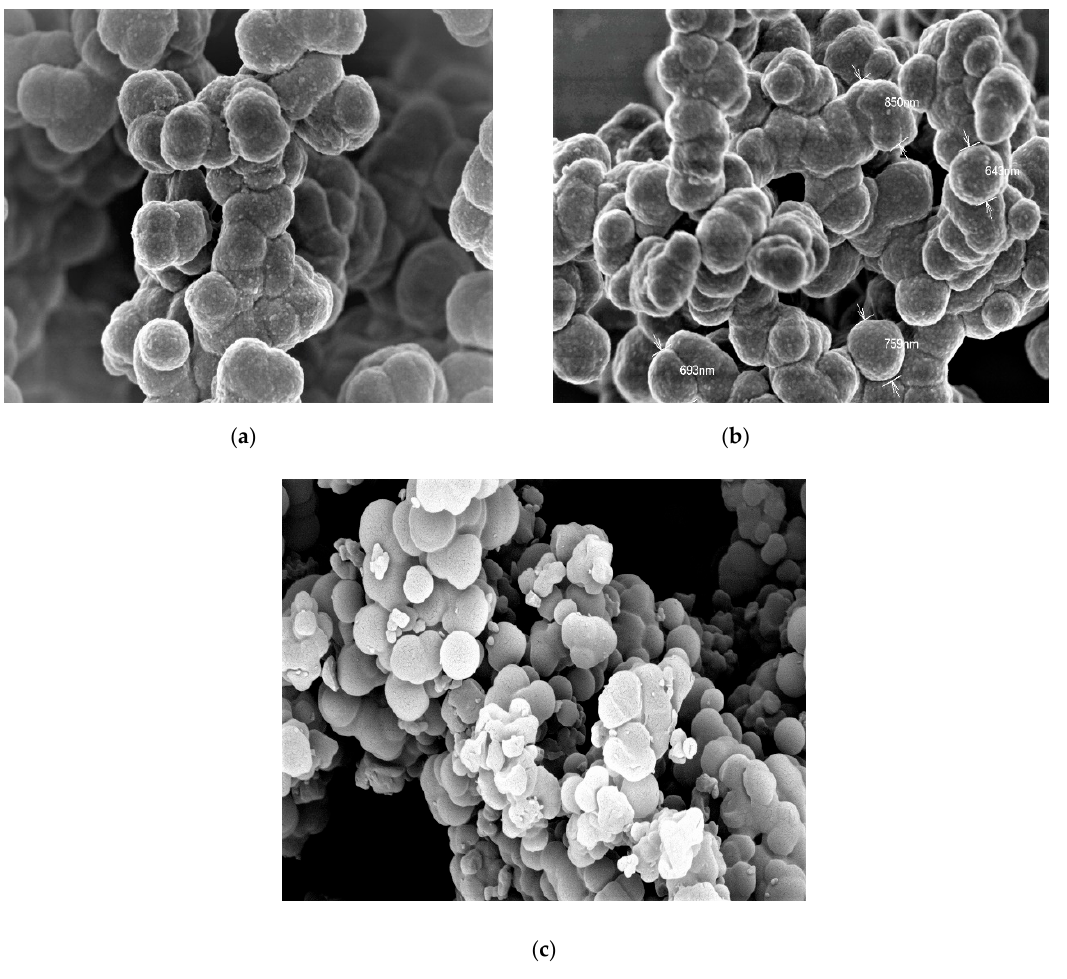
Figure 4. SEM images of ( a ) molecularly imprinted polymers (MIP) / IPU, ( b ) MIP / DU, and ( c ) nonimprinted polymer (NIP) beads. Conditions: scale bar = 2.00 µm, 3.0 kv; 27 mm x20.0kv